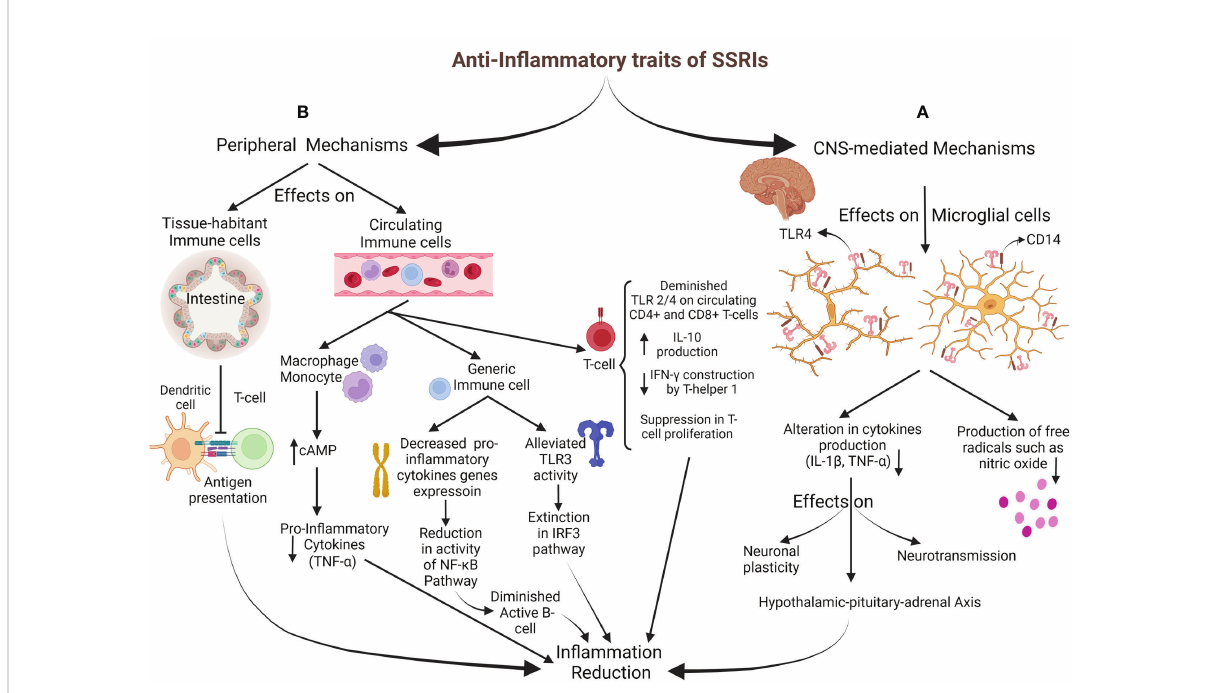
FIGURE 2 Anti-In fl ammatory properties of SSRIs. (A) CNS-mediated mechanisms: SSRIs target microglial cells to impact through TLR4 and CD14, resulting in decreased in fl ammatory cytokines generation (IL-1ß and TNF- a ) and reduced free radicals production. HPA-axis activation via alteration in cytokine network comes up with in fl ammation decrement. (B) Peripheral mechanisms: T-cell activation is inhibited by diminished antigen presentation of intestine-habitant DC. Circulating immune cells are also impressed; increasing cAMP in monocytes and macrophages brings about in fl ammatory cytokines drop. Generic immune cells were targeted through decreased pro-in fl ammatory cytokine gene expression, followed by subsidence in the NF- k B pathway activity and B-cell activation. Also, alleviating TLR3 activity with the inhibition of the IRF3 pathway leads to an in fl ammation drop. SSRIs directly affect T-cell by reducing TLR2/4 expression, a decline in IFN- g generation, a rise in IL-10 production, and disturbance in their